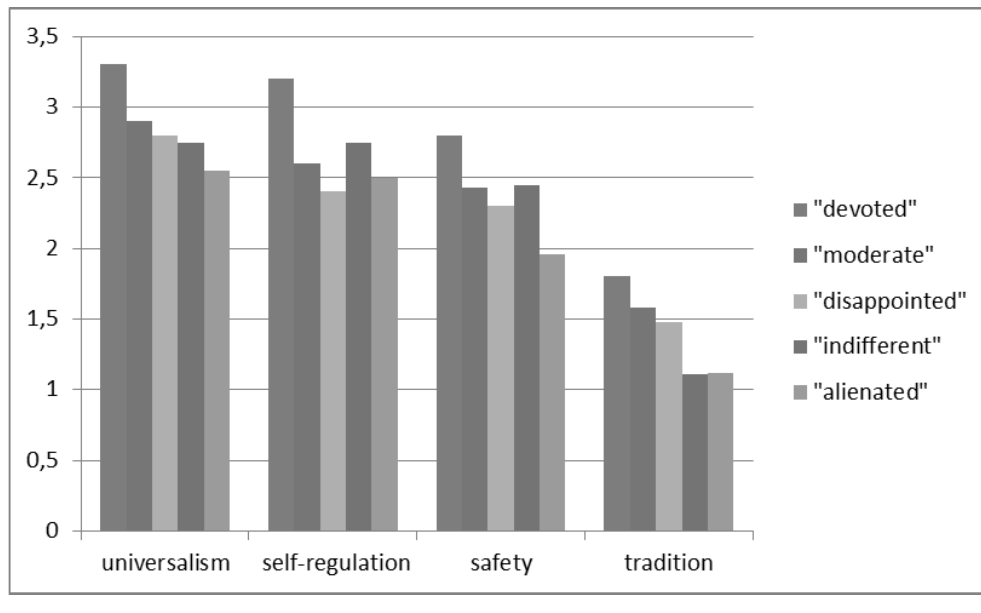
Indicators of value orientations of citizens with various types of civic identity Source: Own